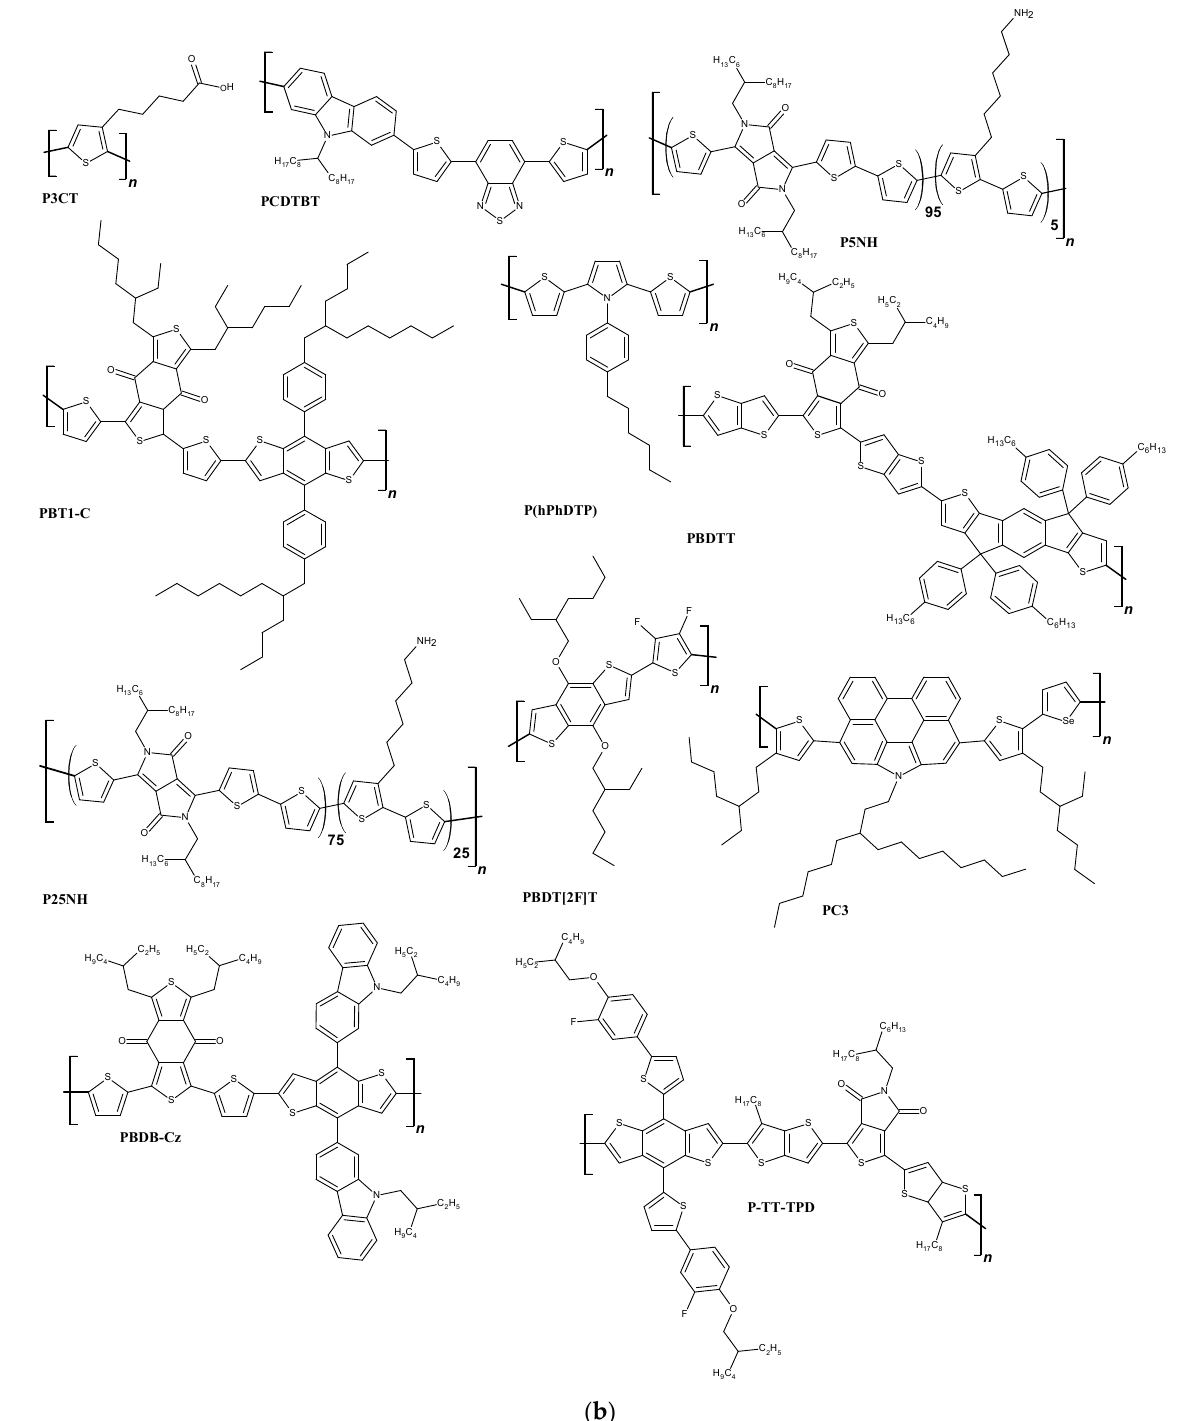
Figure 5. The conventional and inverted architecture of perovskite solar cells ( a ) and the chemical structures of polymers used in PSCs ( b